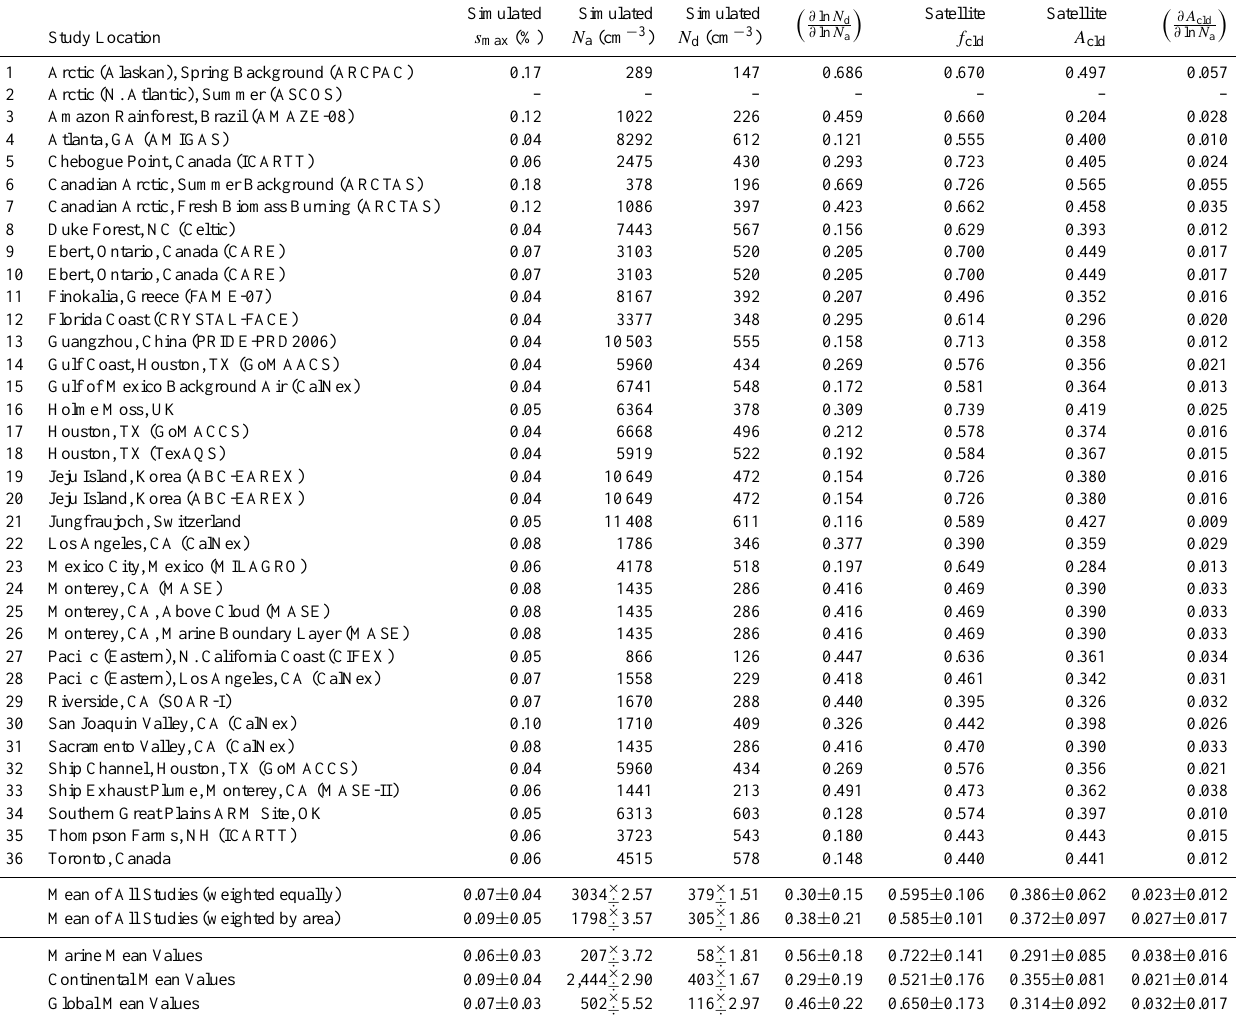
Table 4. Comparison of regional simulated aerosol number concentration, N a ; simulated cloud droplet concentration, N d , at s max ; the